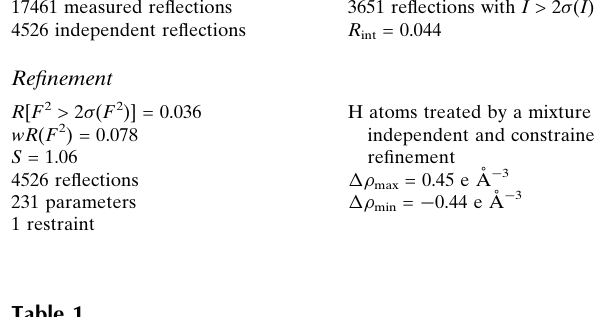
Hydrogen-bond geometry (A˚ , (cid:2)